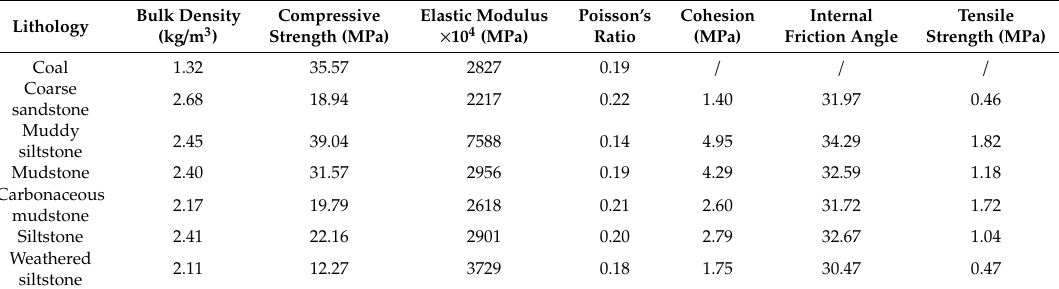
Figure 7. Physical simulation experiment process: (a) Field drilled core; (b) Test specimen; (c) Different experimental stage phenomenon records. Table 1. The parameters of coal and roof of No. 22201 working face.